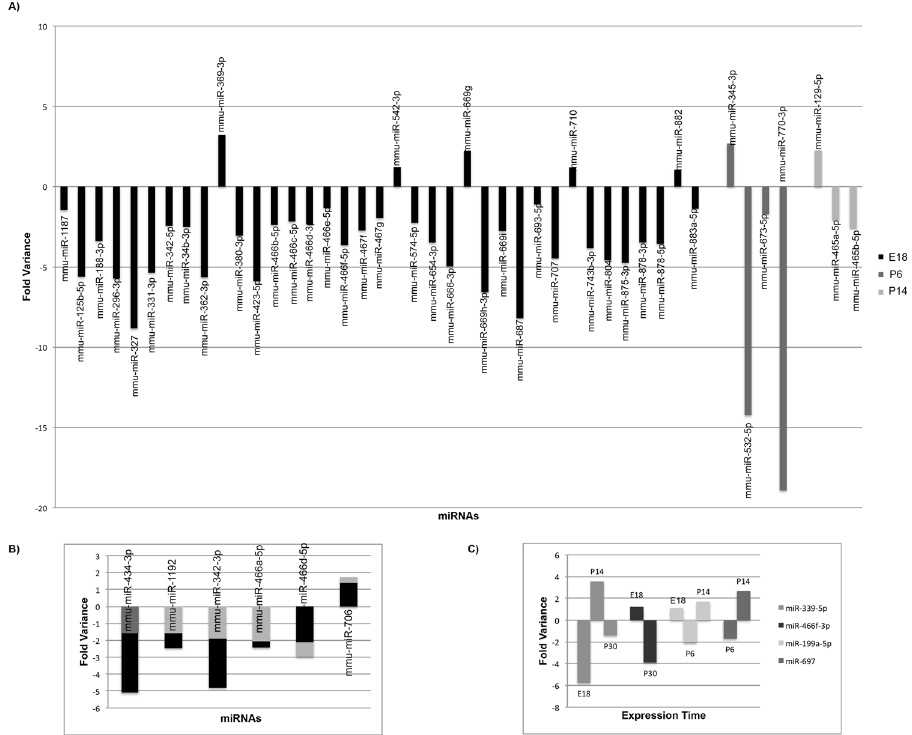
Figure 2. miRNAs differentially expressed between B6 (wildtype) and rd7 (mutant) retinas. ( A ) miRNAs that are differentially expressed at E18, P6, or P14 ( B ) miRNAs differentially expressed between the embryonic time point and one adult time point, and ( C ) miRNAs differentially expressed in more that one time point and have an alternate pattern of expression. Minimum 2 fold change and P <